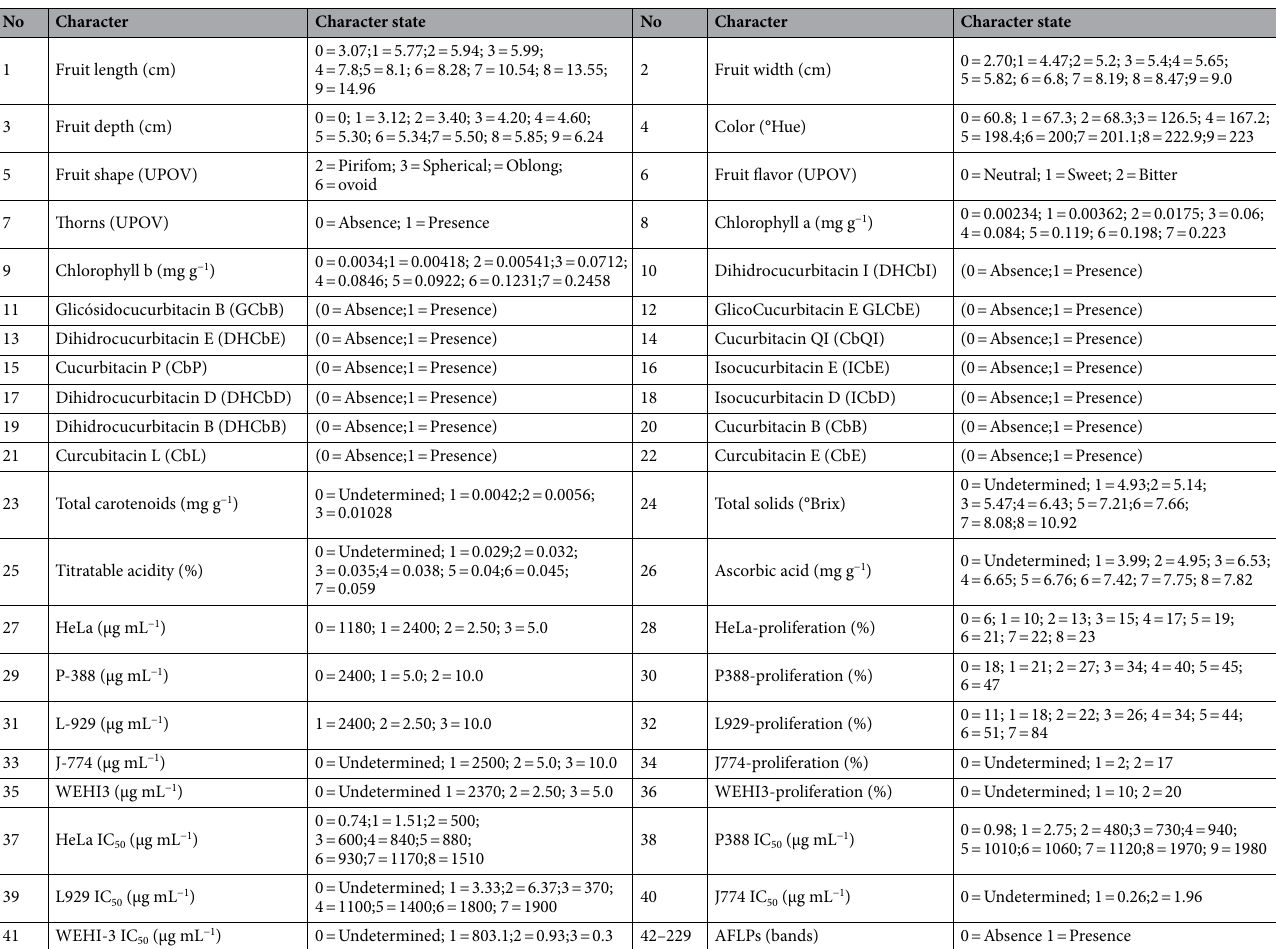
Table 7. Morphological, biochemical, biological effectiveness and genetic characterization variables in S. edule , S. chinantlense , S. compositum for the bioprospecting